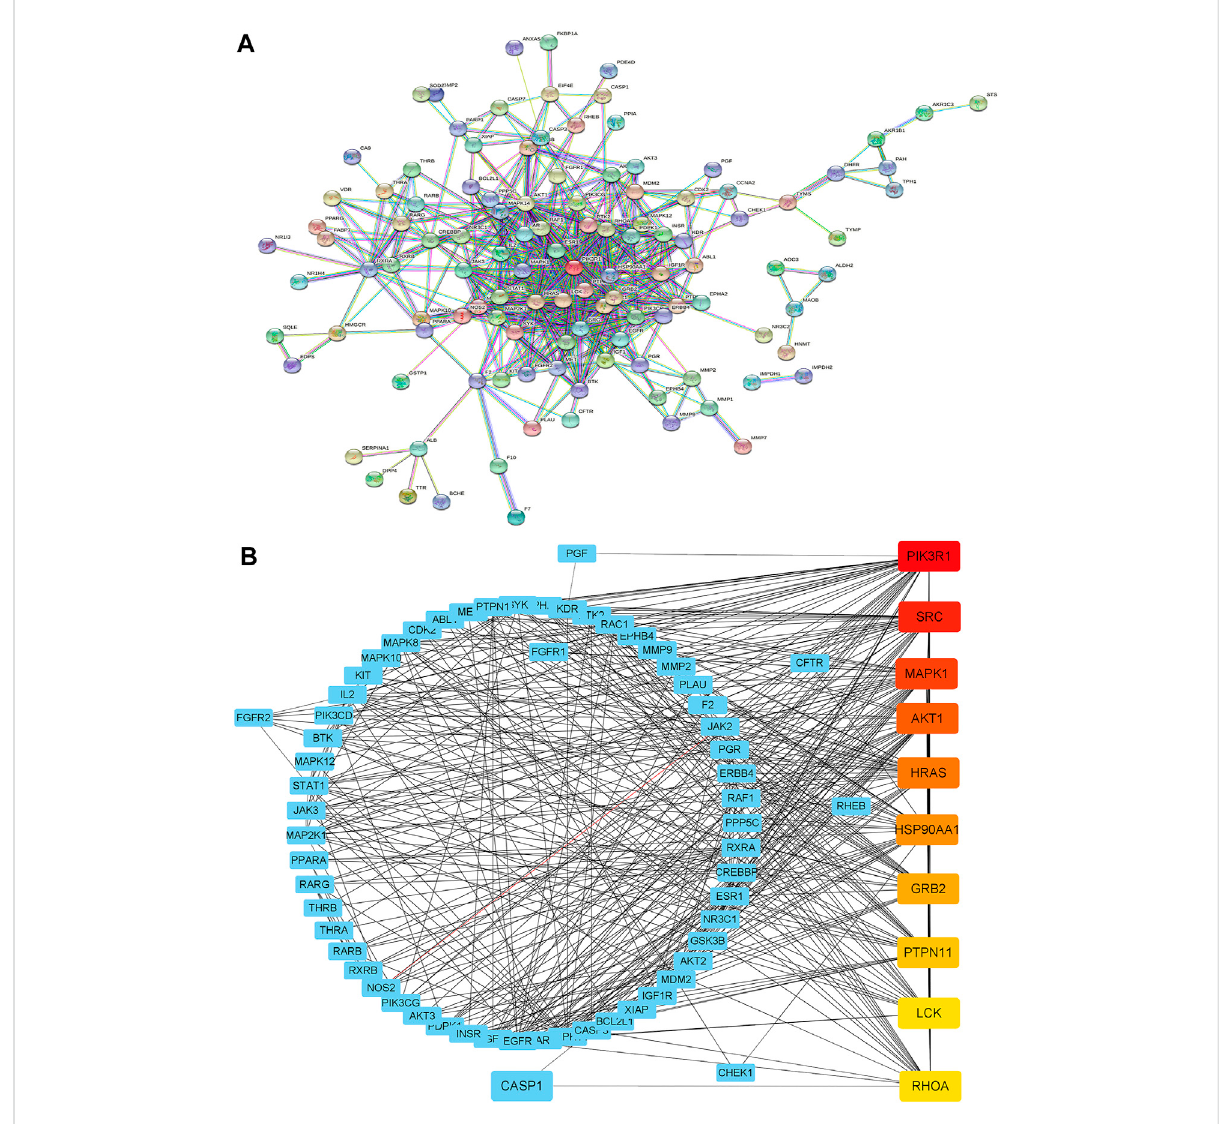
FIGURE 2 Construction of a PPI network (A) Constructing the PPI network by uploading intersecting genes to the STRING database (B) Ranking the top 10 hub genes of the PPI network using CytoHubba in Cytoscape. The darker the red, the higher the degree of connection.